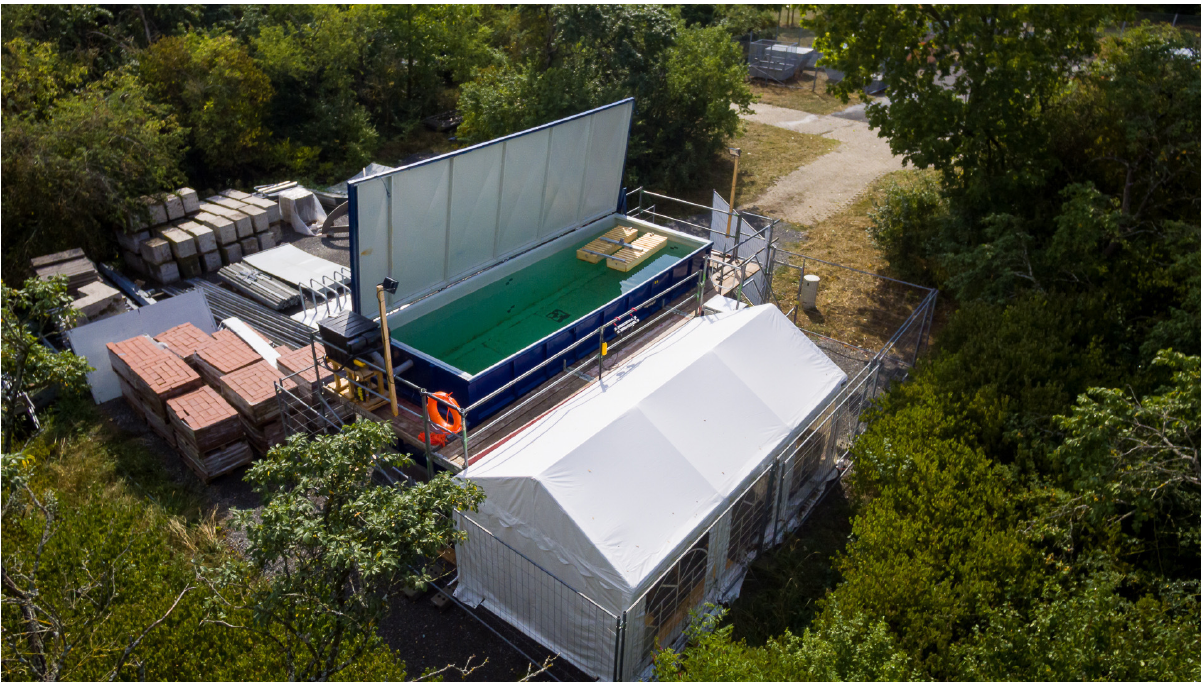
Figure 1. Overview of our test environment. The 7 m x 2 . 4 m x 2 . 4 m Roll-on/Roll-off container filled up with around 40 000 l of water, a tent to have a dry working place and the scaffolding around the container are visible. luminosity at 4000 K color temperature and a beam angle of 44 ◦